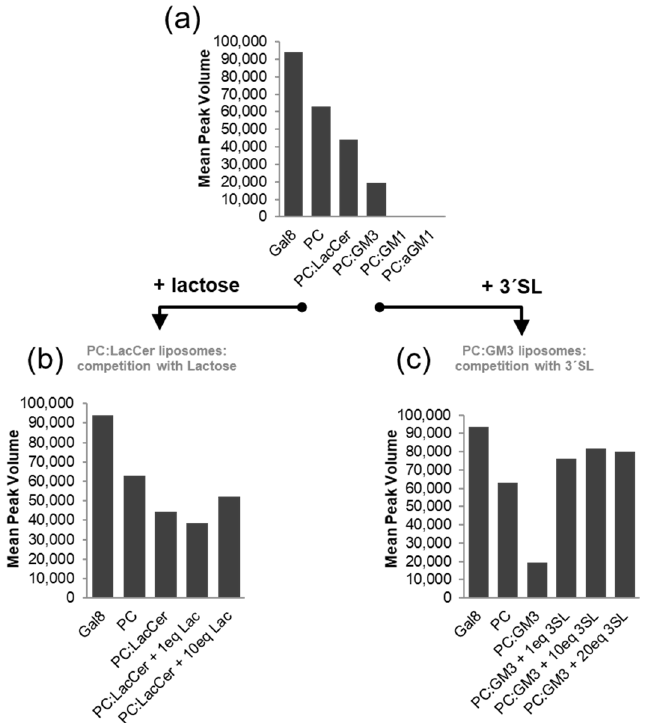
Figure 5. Competition experiments with Gal8-N. ( a ) Peak volume reduction of 15 N-Gal8-N in the presence of differently functionalized liposomes: PC only, or one equivalent (with respect to the lectin) of glycolipid (LacCer, GM3, GM1, or aGM1). ( b ) Peak volume recovery of 15 N-Gal8N/LacCer containing liposomes upon the addition of 10 and 20 equivalents of lactose as binding competitor; ( c ) Peak volume recovery of 15 N-Gal8N/GM3 containing liposomes upon the addition of 10 and 20 equivalents of 3 ′ SL as binding competitor.